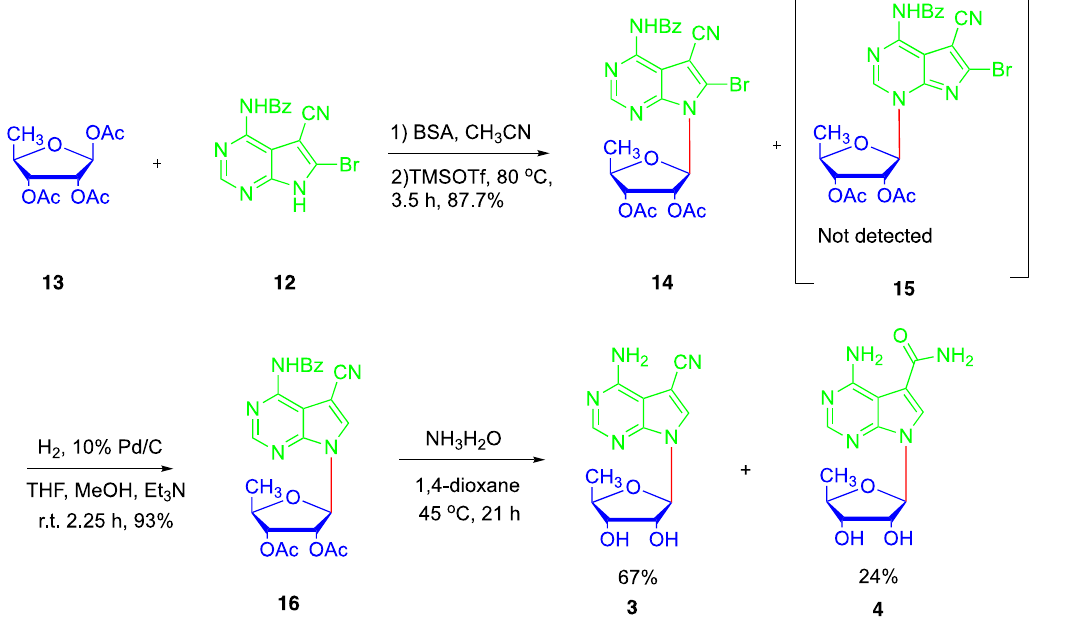
Scheme 2. Total synthesis of 5 (cid:48) -deoxytoyocamycin and 5 (cid:48)